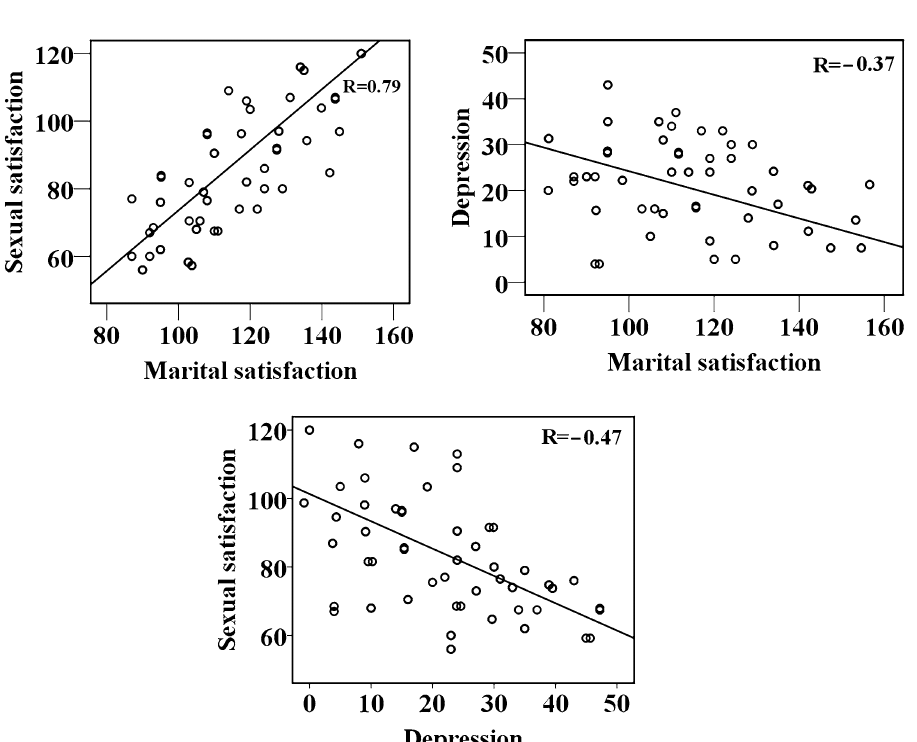
Figure 2. Scatter plots for correlations in the patient group between sexual satisfaction, depression, and marital